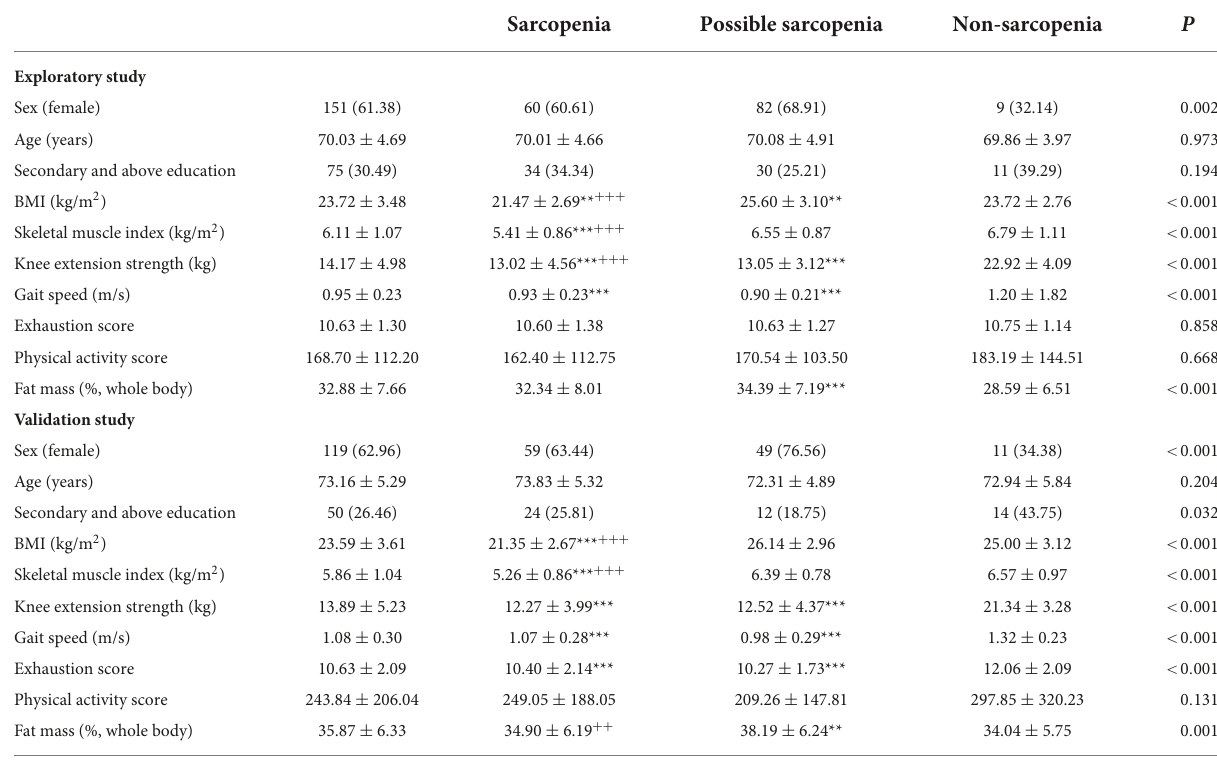
TABLE 1 Demographic, physical, and functional status of sarcopenia groups in all